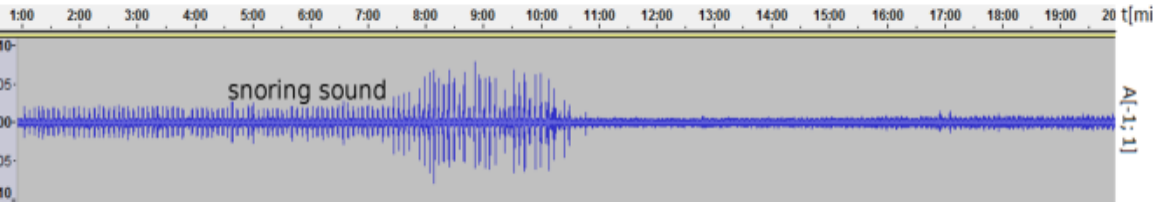
Figure 11. Recorded sound data of subject No.